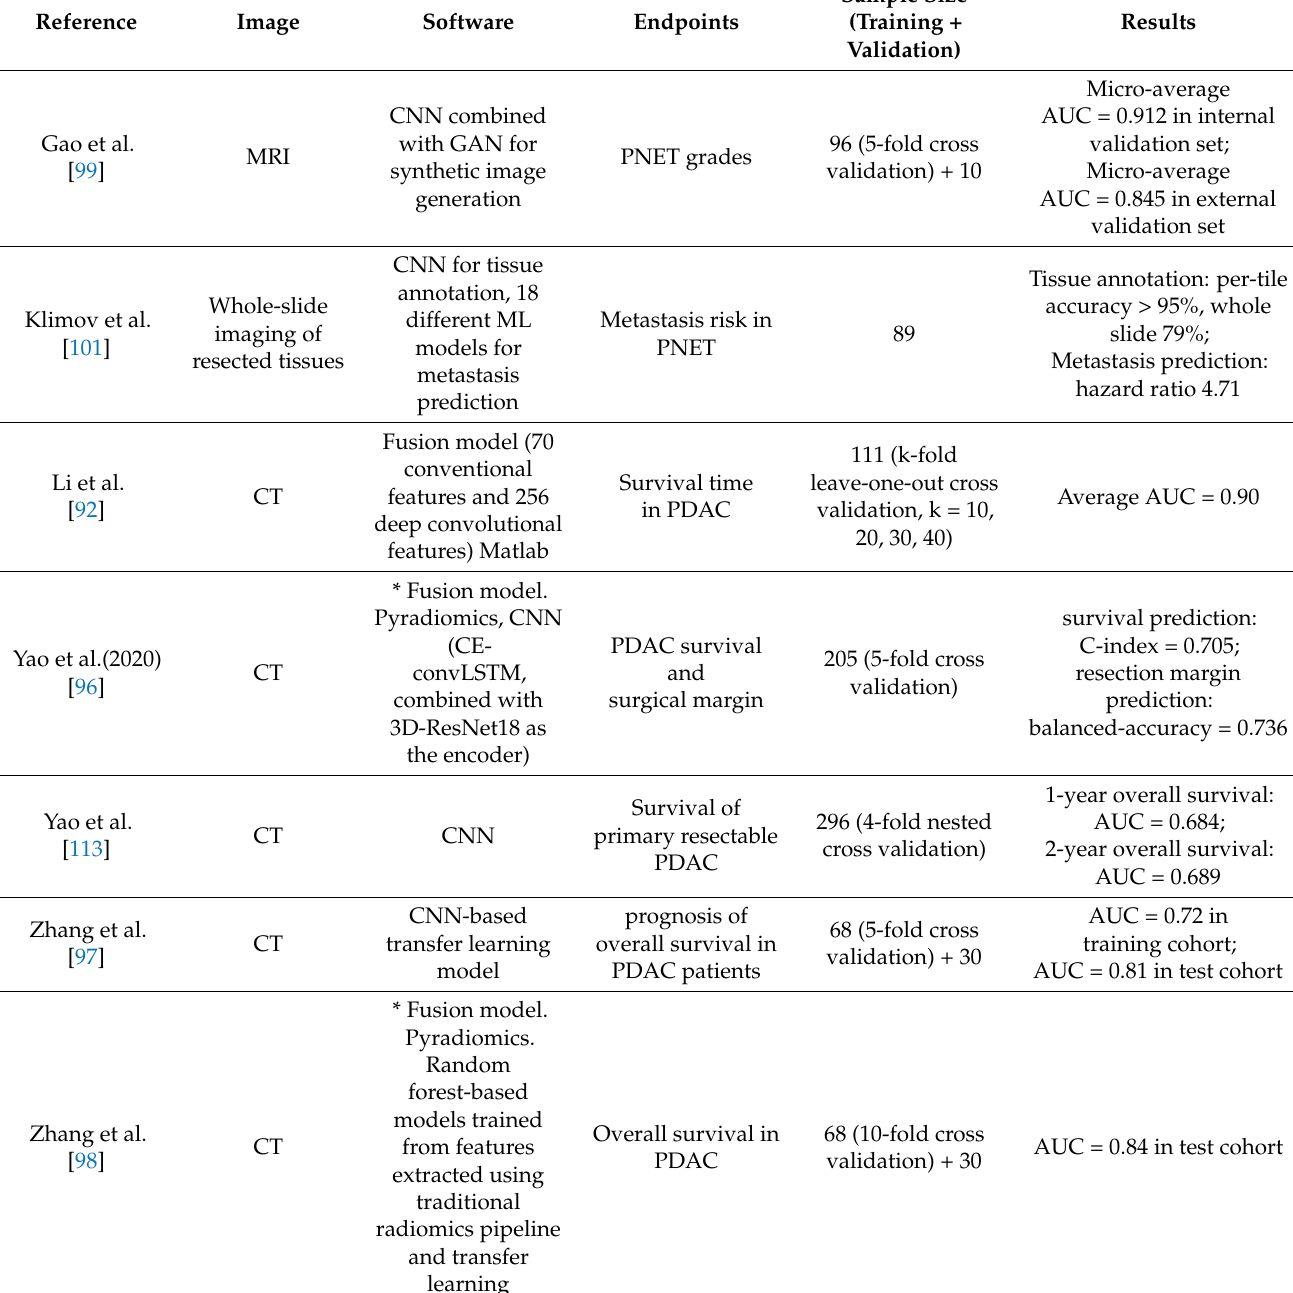
Table 6. Deep learning studies in pancreatic cancer